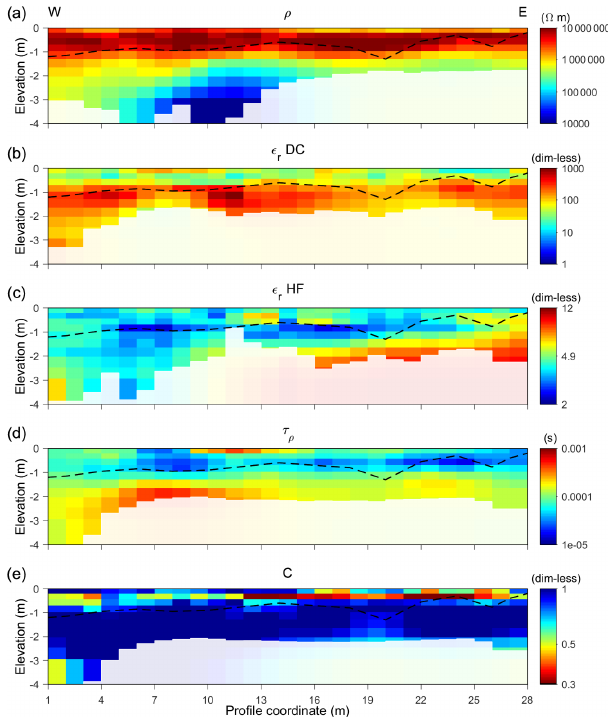
Figure 7. Result of the AarhusInv 2-D inversion for the data from the Schilthorn area along the profile B-SCH denoted in Fig. 1. The figure shows the sections of the five Cole–Cole parameters (a–e) de- fined by Eq. (5). The dashed line shows the separately measured depth of the snow layer, and the brighter parts represent the area where the depth of investigation is